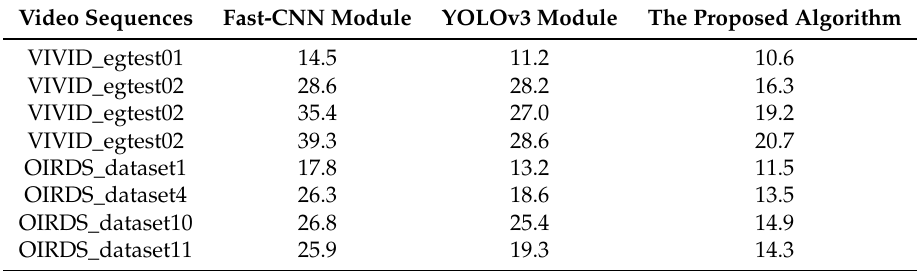
Table 4. Processing time of the Fast-CNN module, YOLOv3 module, and improved YOLOv3 framework (s).